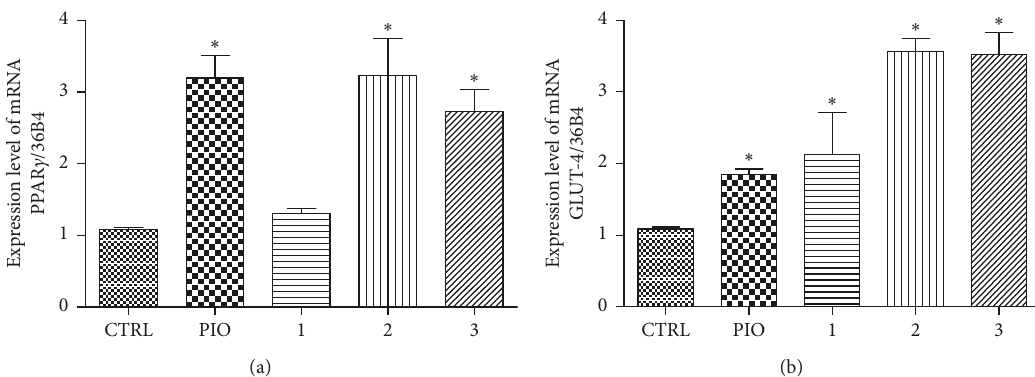
Figure 3: Changes in the expression of PPAR c (a) and GLUT-4 (b) induced by hybrid bioisosteres 1–3 and pioglitazone. ANOVA with post hoc Dunnett’s test ( n � 5, mean ± SEM, p < 0 . 001 compared with CTRL